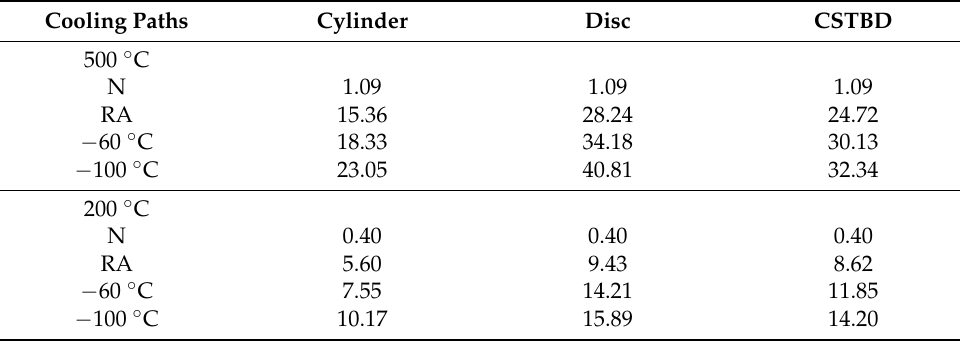
Figure 5. Differential sketch map of the cooling process. Table 2. Cooling rates (°C/min) of specimens in different cooling paths.